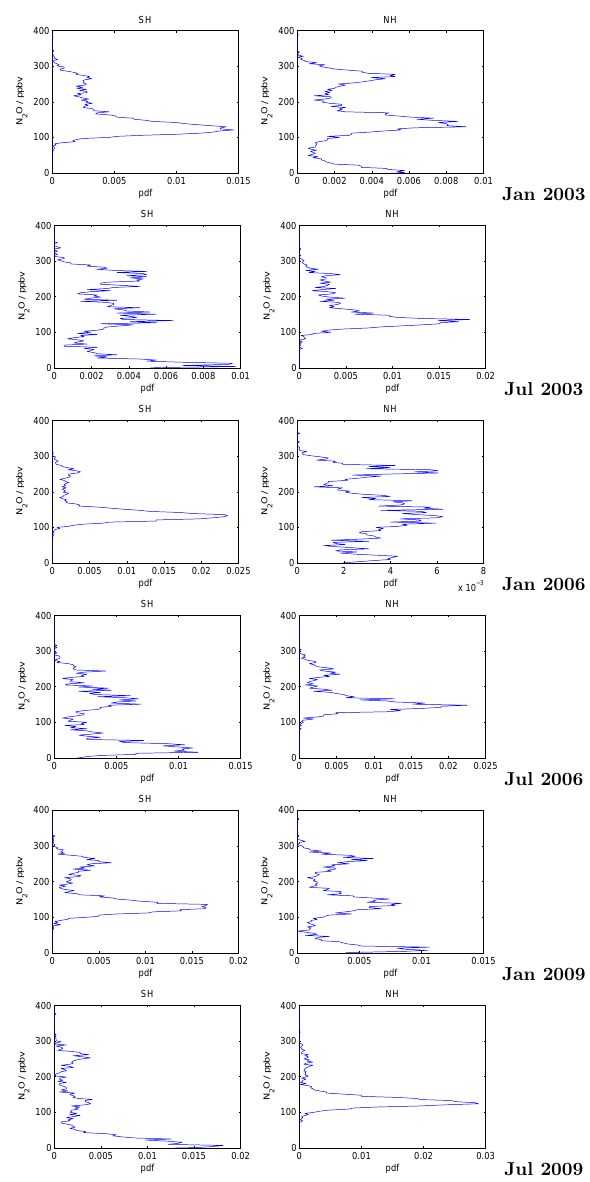
Fig. 14. Probability Density functions (PDFs) derived from Odin/SMR measurements (NH and SH) at 650K for January and July 2003, January and July 2006 and January and July 2009. The QBO was in its easterly phase in 2003 and 2009 and in its westerly phase in 2006. Note: the x-scale is not the same for all figures.